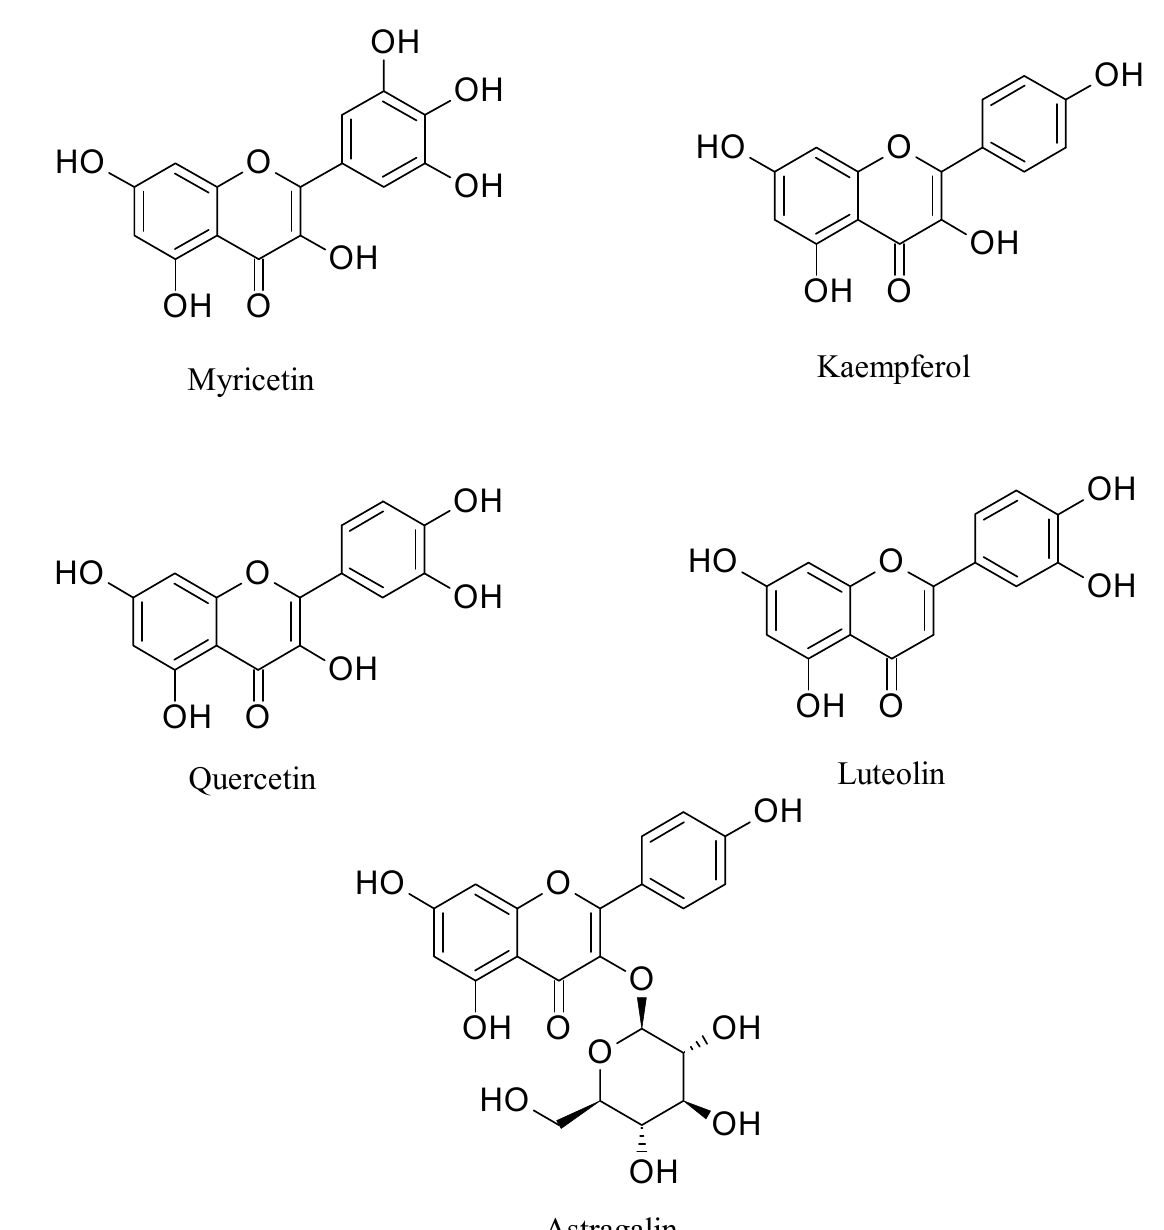
Figure 6. Chemical structures of major bioactive compounds identified in the MECR.